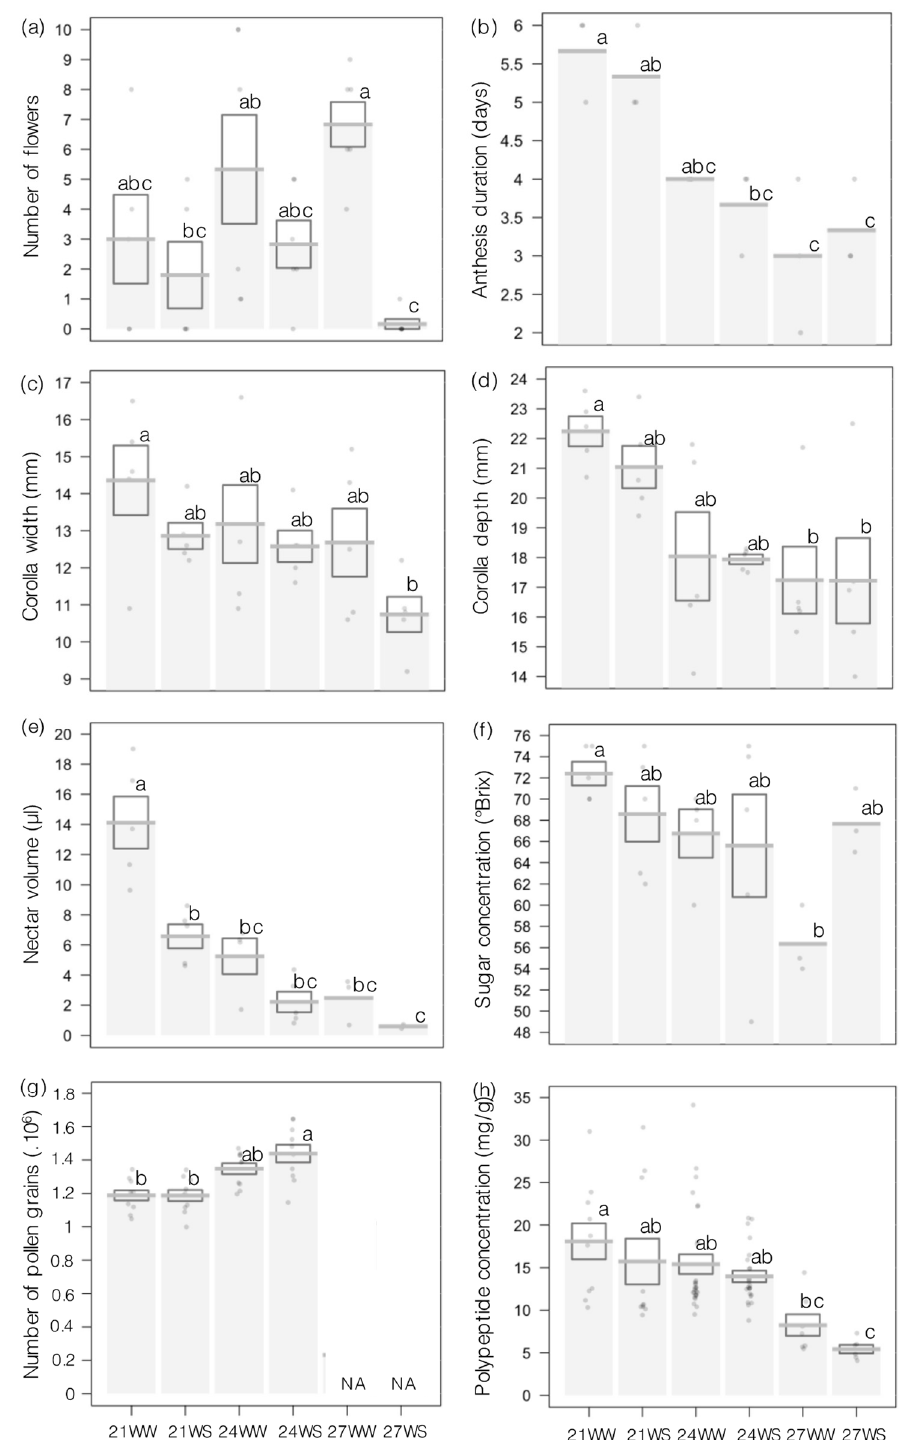
Figure 2. Effects of increasing temperature and water stress on floral traits and resources of Impatiens glandulifera plants 2 weeks after beginning treatment. ( a ) Number of flowers per plant, ( b ) anthesis duration per flower, ( c ) corolla width, ( d ) corolla depth, ( e ) nectar volume per flower, ( f ) sugar concentration in nectar, ( g ) number of pollen grains per flower and ( h ) polypeptide concentration in pollen. N = 5 per treatment, except for number of pollen grains and polypeptide content, with N = 10. Data are presented as means ± standard errors (SE) as barplots with individual data points shown in gray. Treatments followed by different letters are significantly different at p < 0.05. 21, 21 °C; 24, 24 °C; 27, 27 °C; WS, water-stressed; WW, well-watered. 21WW = control.